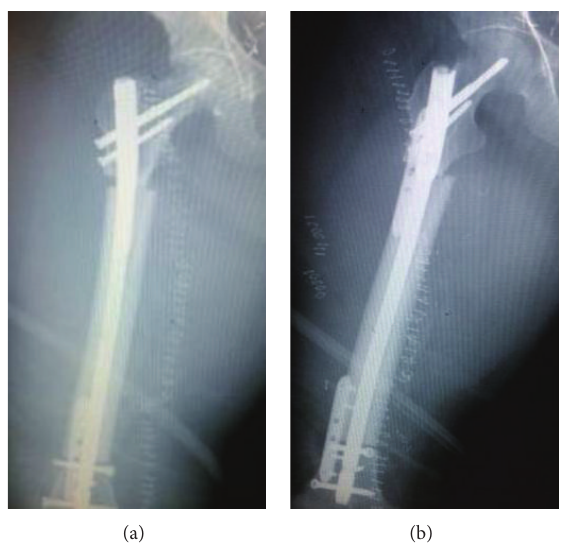
Figure 5: ((a), (b)) Early postoperative AP and lateral X-rays.